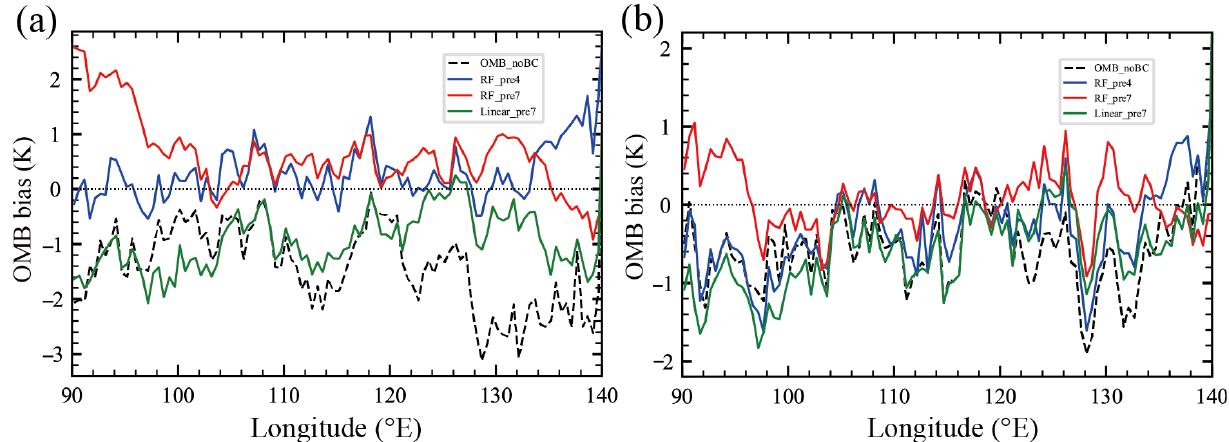
Figure 5. Variations in the OMB biases (unit: K) with respect to the predictors of longitude for AGRI ( a ) channel 9 and ( b ) channel 10 valid at 0600 UTC 19 July 2021.